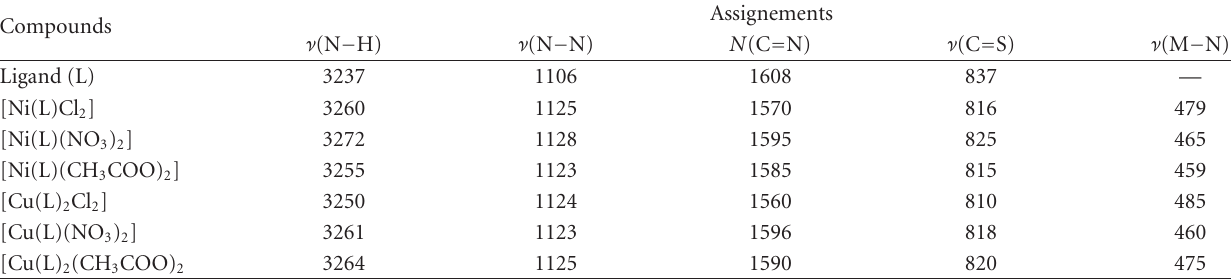
Table 2: Important infrared spectral bands (cm − 1 ) and their assignments.